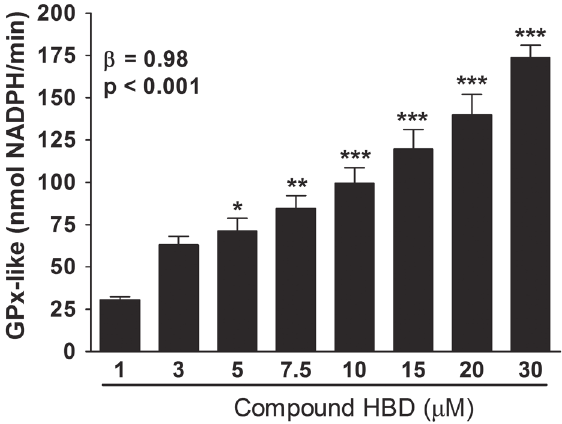
Figure 4 - The GPx-like activity of Compound HBD (1- 30 µM). Linear regression of GPx-like activity was used in order to verify the concentration-dependent effect. Results are represented as mean ± SEM from at three independent experiments (one-way